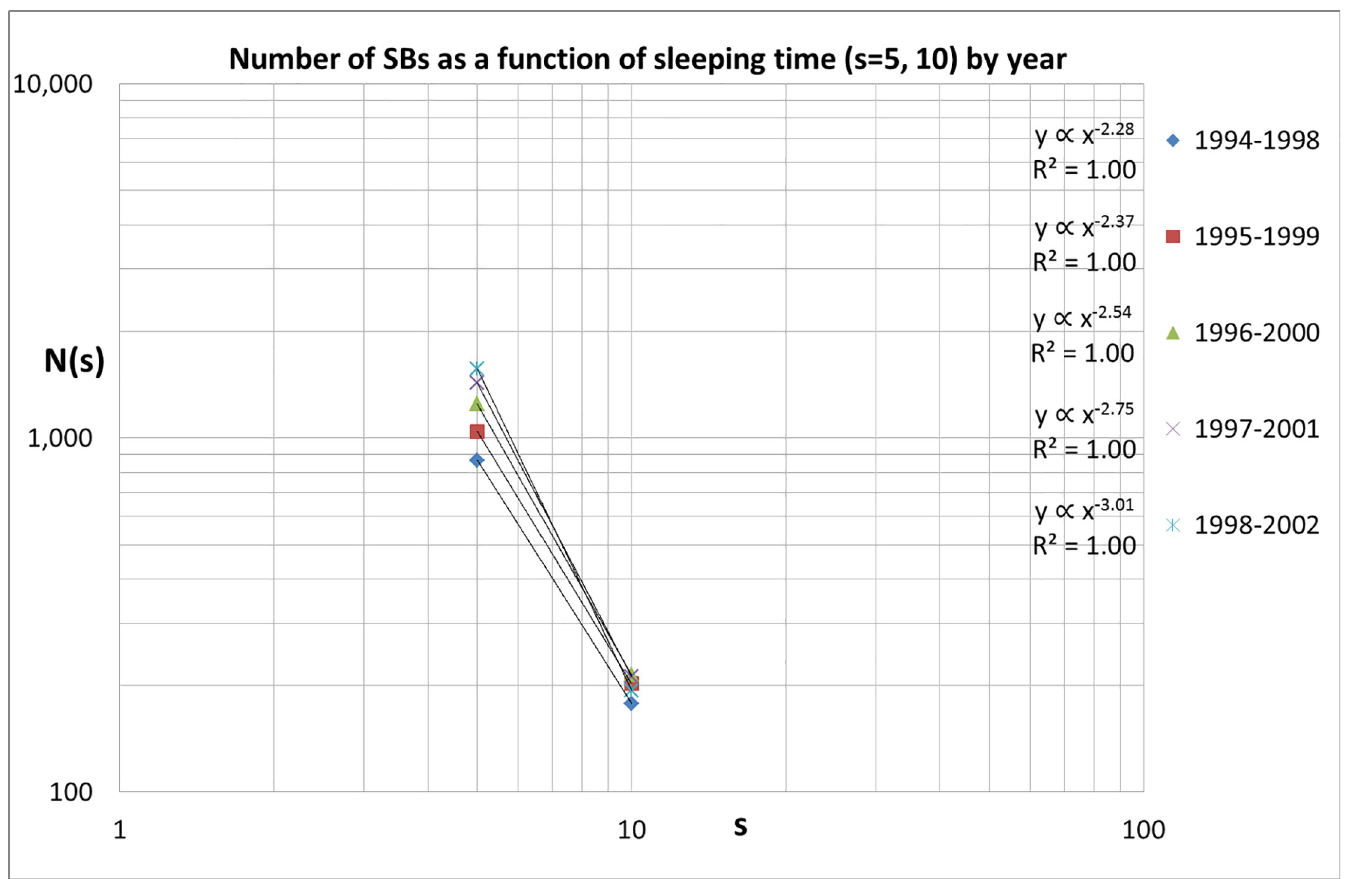
Fig 6. Numbers of SBs for s = 5 and 10, between 1994 and